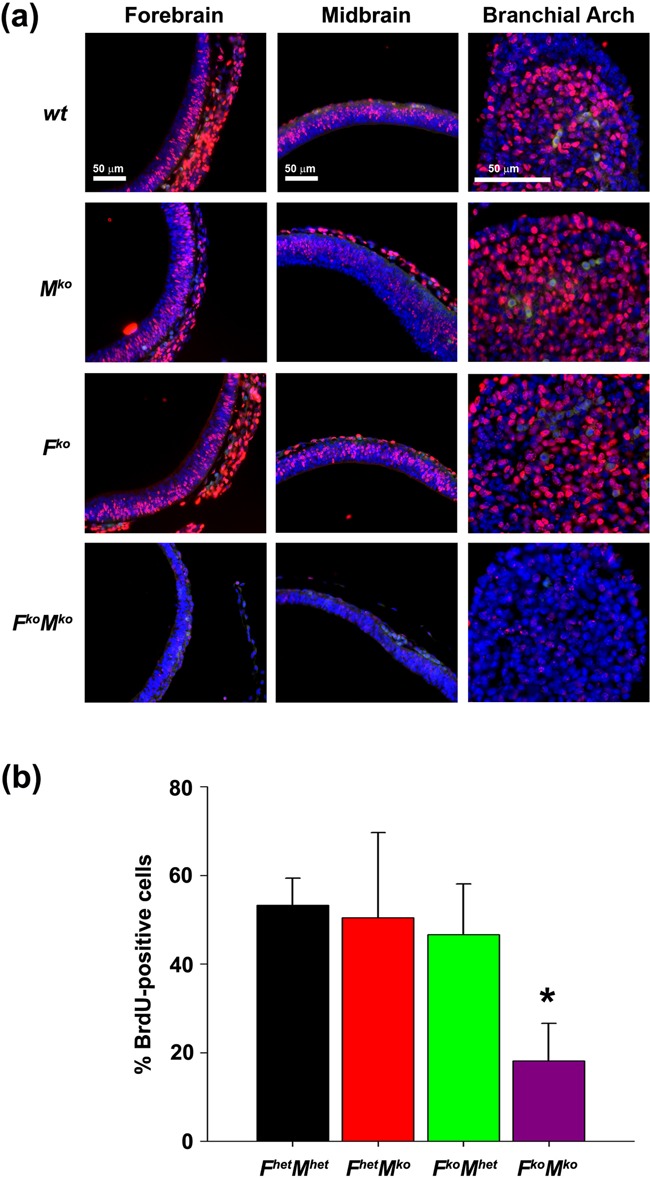
Proliferation defect in FkoMko embryos. (a) BrdU incorporation (red) in E10.5 embryos; blue, DAPI (nuclei); yellow, erythrocyte auto fluorescence. (b) Quantification of % of BrdU-positive cells in branchial arch. Data represent the mean number of BrdU-labeled cells per genotype ±SD (n = 3). *P < 0.05 by one-way ANOVA followed by Holm–Sidak post hoc test for FkoMko versus other genotypes.